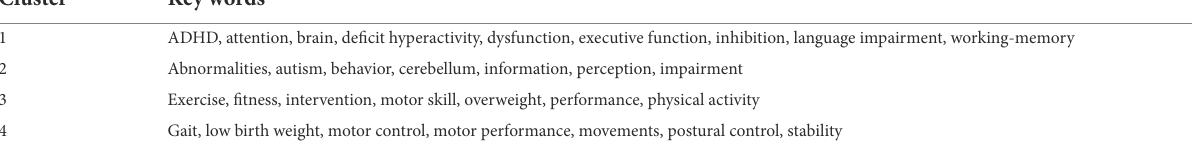
TABLE 6 Cluster analysis of keywords regarding cognitive function in